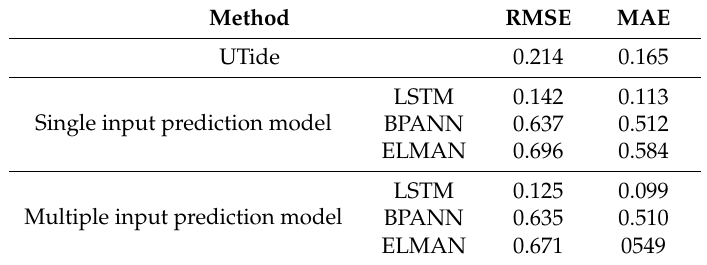
Table 2. Comparison RMSE and MAE of the tidal current velocity prediction 20 m under the sea surface.